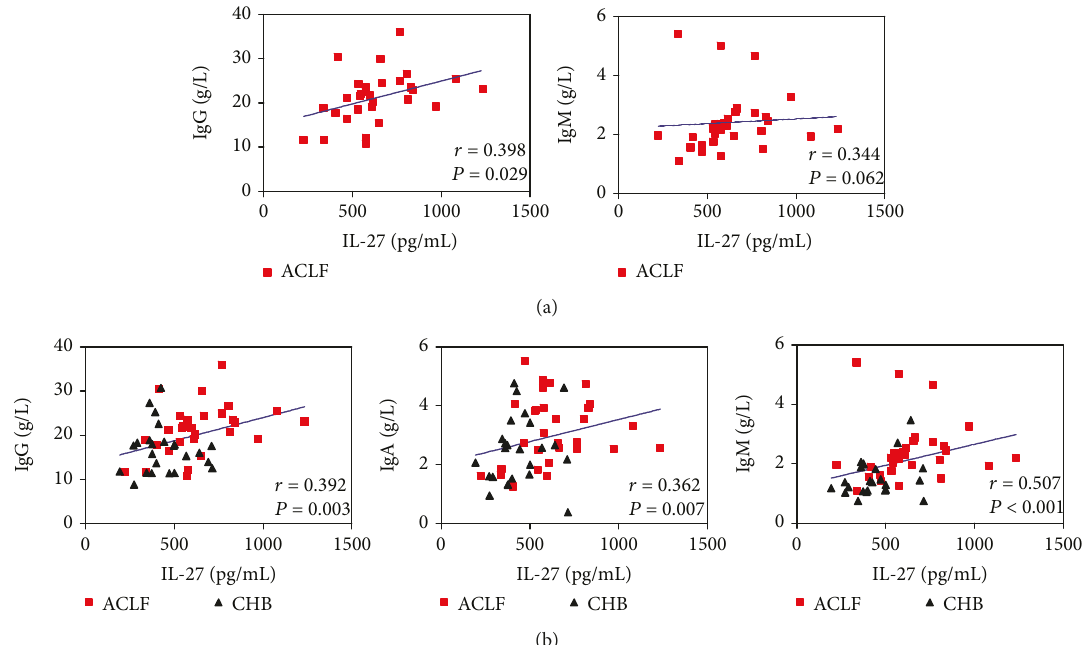
Figure 4: IL-27 levels were positively correlated with the expression of immunoglobulins. (a) IgG levels were found to be positively correlated with IL-27 levels; and a positive correlation trend was found between IgM levels and IL-27 levels in HBV-ACLF patients. (b) Positive correlations were found between IL-27 levels and serum immunoglobulin levels (IgG, IgA, and IgM) in HBV-infected patients. Solid line: linear growth trend; r : correlation coe ffi cient. P values are shown.